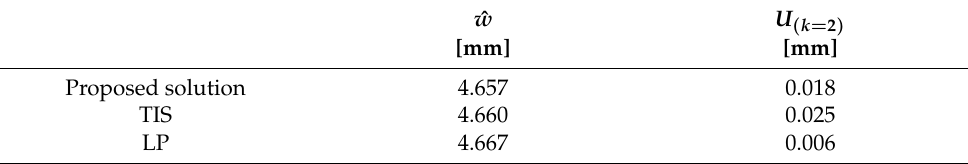
Table 1. Comparisons between the average groove width measured with the three different devices.